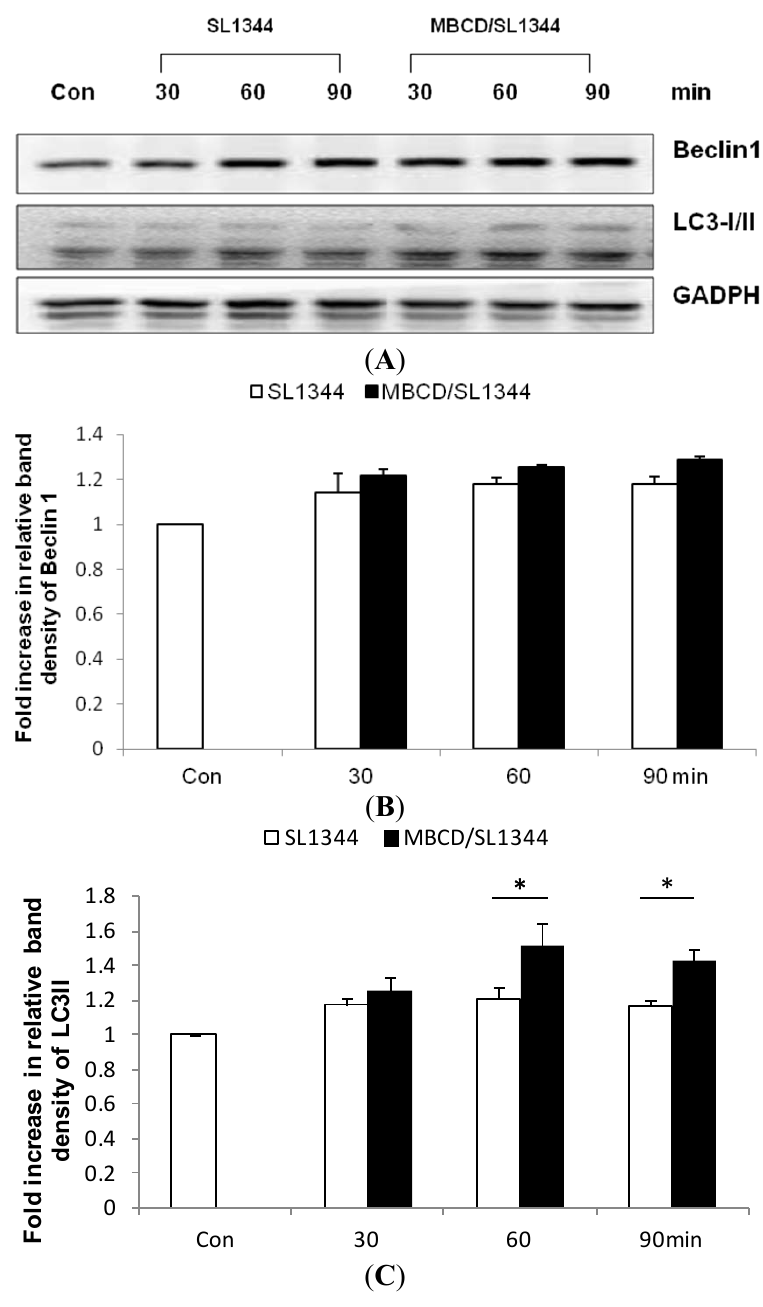
Figure 1. The role of membrane cholesterol on the autophagy proteins expression in Salmonella -infected Caco-2 cells. Caco-2 cells were uninfected (Con) or infected by wild-type S . typhimurium strain SL1344 at indicated times, in the presence or absence of methyl-beta-cyclodextrin (MBCD). Immunoblots were performed on whole cell lysates with an antibody to detect autophagy Beclin 1 and LC3II proteins expression, or GAPDH for normalization of proteins. Representative immunoblots ( A ) and densitometric quantification of immunoreactive bands ( B , C ) were shown; The relative band intensities of Beclin 1 ( B ) and LC3II ( C ) in untreated (white) and treated (black) Caco-2 cells were quantified as fold increases compared with the control cells. Each value represents the mean ± standard error of mean (SEM) of 3 independent experiments. An asterisk indicates a significant difference ( p <